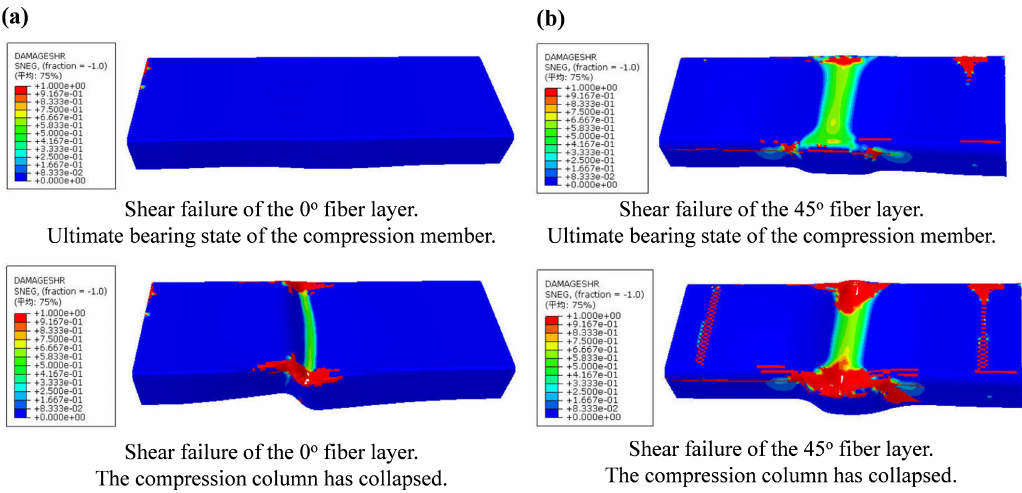
Figure 20: Fiber layer shear failure area distribution of compression columns at different states: (a) DCYG-A and (b)